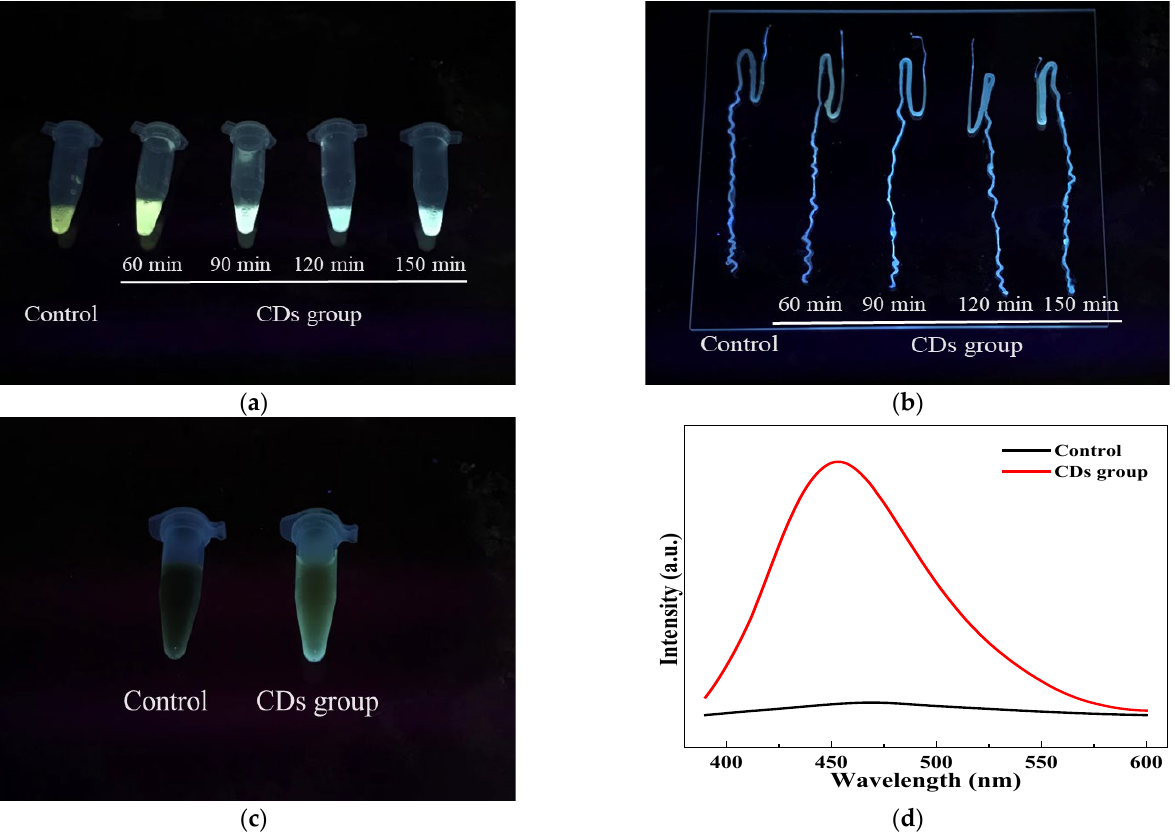
Figure 5. Fluorescence images of ( a ) silkworm blood, ( b ) silk gland, ( c ) feces aqueous extract and ( d ) PL spectra of silkworm feces aqueous extract (measured with an excitation wavelength of 370 nm).